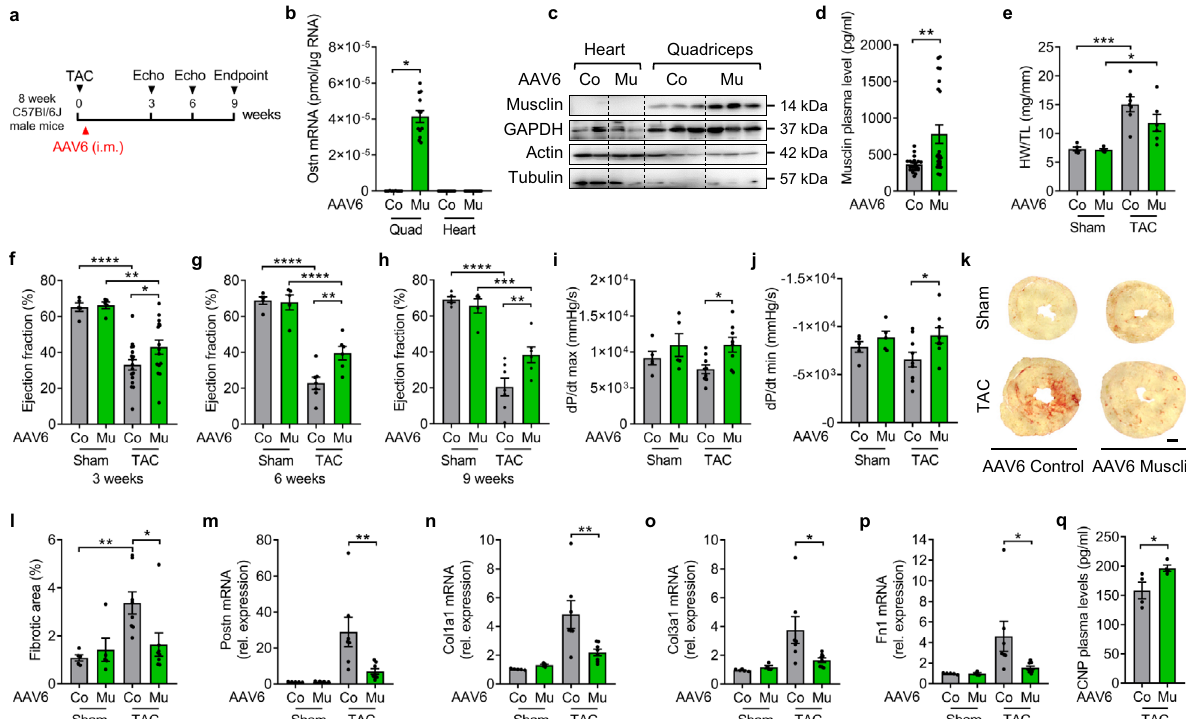
Fig. 3 AAV6-mediated overexpression of Musclin in skeletal muscle attenuates left ventricular dysfunction and myocardial fi brosis during long-term pressure overload. a Scheme depicting the experimental time line. b mRNA level of Ostn (Musclin) 9 weeks after TAC and intramuscular application of AAV6 control (Co) or AAV6 Musclin (Mu) vector ( n = 12/group), *p = 0.036 ( c ) Immunoblot for Musclin 9 weeks after TAC and intramuscular application of AAV6 Co or AAV6 Mu. GAPDH, Actin and Tubulin are loading controls. The size of the proteins is indicated in kDa. d Musclin plasma levels in AAV6 Co ( n = 21) or AAV6 Mu ( n = 22) treated mice, ** p = 0.0029. e Heart weight/tibia length (HW/TL) ratio in AAV6 Co (sham n = 5, TAC n = 7) or AAV6 Mu (sham n = 5, TAC n = 6) treated mice 9 weeks after sham or TAC surgery, *** p = 0.0004, * p = 0.0316. f – h Echocardiographic ejection fraction 3 weeks (all sham n = 5/group, TAC AAV6 Co n = 17, TAC AAV6 Mu n = 15), **** p < 0.0001, ** p = 00015 and * p = 0.0293 ( f ), and 6 weeks after surgery, **** p < 0.0001 in AAV6 Control and AAV6 Musclin groups for sham vs. TAC surgery, ** p = 0.0021 ( g ), and 9 weeks after surgery, **** p < 0.0001, *** p = 0.0006 and ** p = 0.0051 ( h ). Cardiac systolic contractility (dp/dt max, i ), * p = 0.0122 and diastolic relaxation (dp/dt min, j ), * p = 0.0164 determined by left ventricular catheterization in the indicated mice (all sham n = 5/group, TAC AAV6 Co n = 9, AAV6 Mu n = 8) 9 weeks after sham or TAC surgery. Representative Sirius red-stained heart sections ( k ) and quanti fi ed myocardial fi brotic area ( l ) and of mice treated as shown (all sham n = 5/group, all TAC n = 8/group, 9 weeks after surgery), ** p = 0.0093 and * p = 0.0206. Scale bar: 500 µ m. m – p qPCR analysis of the indicated fi brosis genes 9 weeks after sham or TAC surgery (sham AAV6 Co n = 5, sham AAV6 Mu n = 4, TAC AAV6 Co n = 7, TAC AAV6 Mu n = 8), ** p = 0.0064 ( m ), ** p = 0.0081 ( n ), * p = 0.0248 ( o ), * p = 0.0369 ( p ). q Mature CNP plasma levels in AAV6 Co or AAV6 Mu treated mice 3 weeks after TAC surgery ( n = 4/group), * p = 0.0462. Data are shown as mean ± standard error of the mean (SEM). * p < 0.05, ** p < 0.01, *** p < 0.001, **** p < 0.0001 as determined by two-tailed Student ’ s t test ( d , q ) or by one-way ANOVA followed by the Holms – Sidak ’ s multiple comparisons test (other bar graphs). Source data are provided as a source data fi